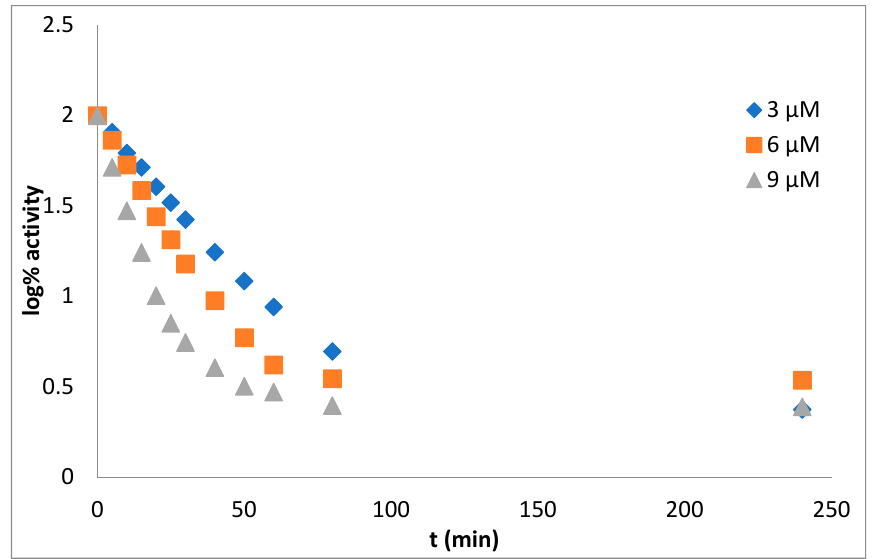
Figure 2. The dependence log% A vs. time. Enzyme: butyrylcholinesterase, derivative 5c , concentration of inhibitor: 3 µM (rhomb), 6 µM (square), 9 µM (triangle).